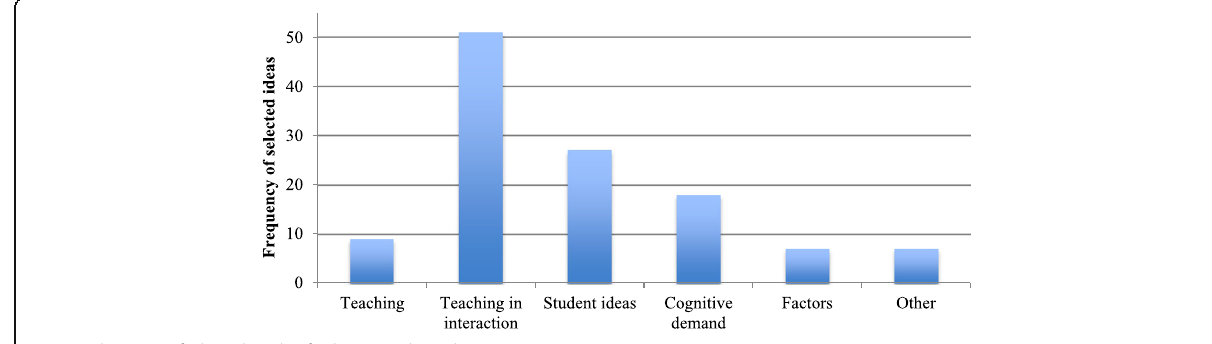
Fig 2 Substance of ideas that the facilitators